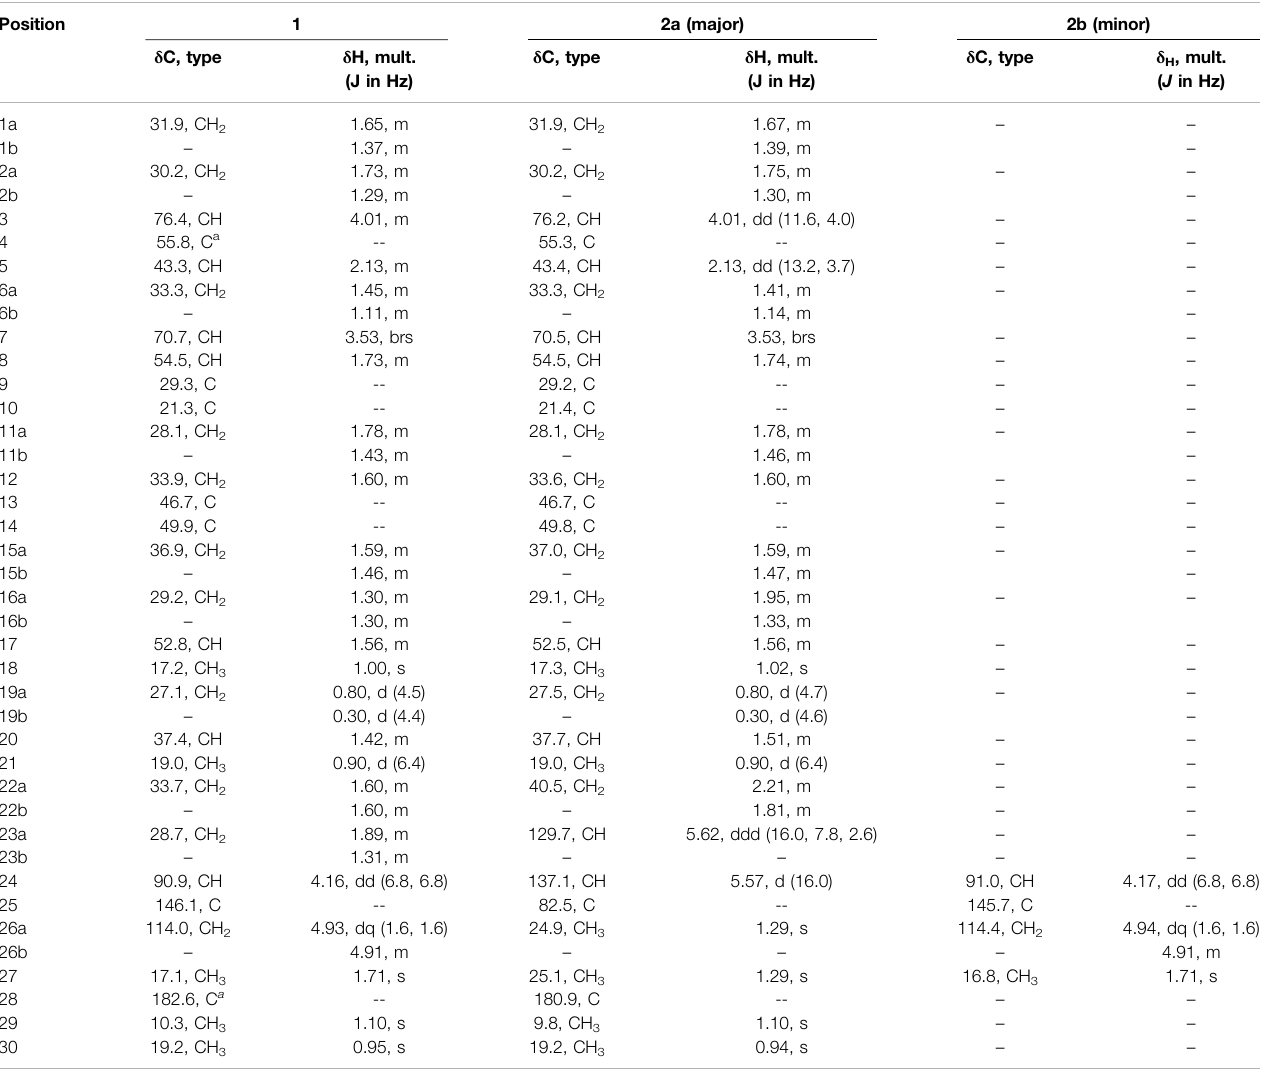
TABLE 1 | 1 H and 13 C NMR data ( δ , in ppm) for compounds 1 and 2a , 2b .